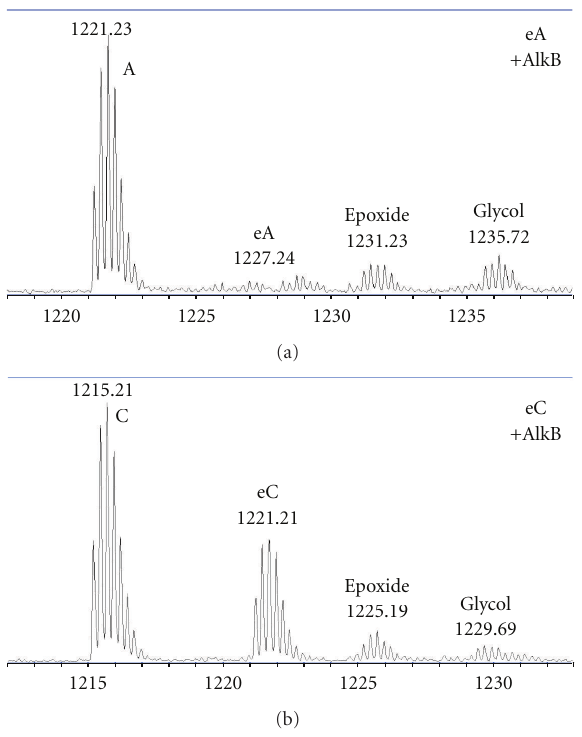
Figure 4: ESI-TOF analysis of 16 mer reactants and products from the in vitro incubation reactions of eA and eC lesions with the AlkB protein. Data represent the − 4 charge envelopes; multiple ion mass peaks associated with each envelope reflect mostly the number of 13 C atoms in each − 4 charged packet. The monoisotopic peak (all 12 C, 14 N, etc.) value is labeled above each peak envelope. (a) eA + AlkB; (b) eC +